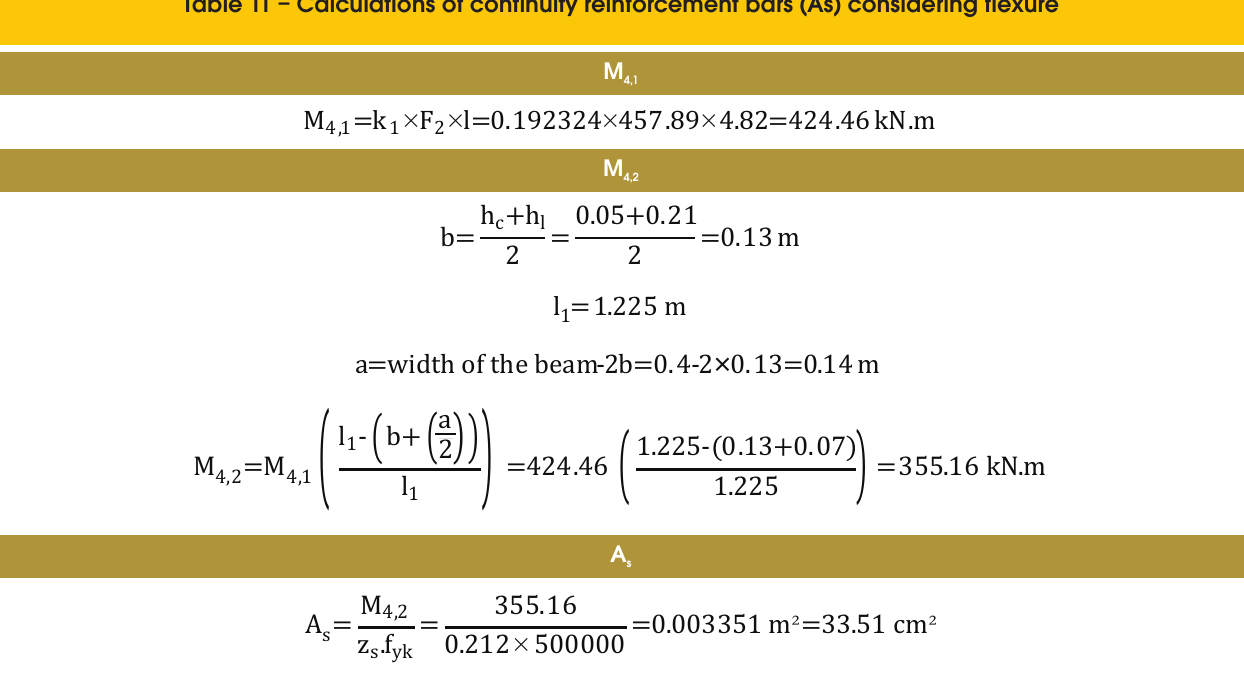
Table 11 – Calculations of continuity reinforcement bars (As) considering flexure